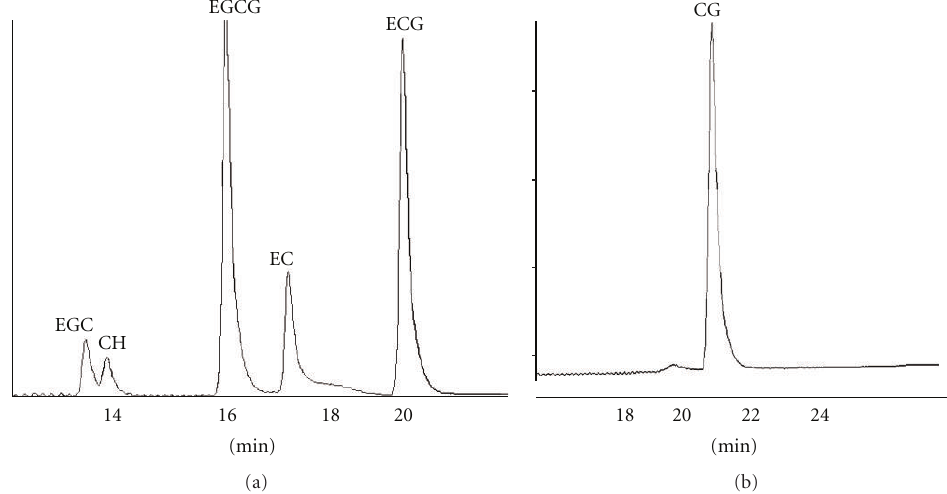
Figure 3: (a) HPLC chromatograms of standard catechins (EC: ( − )-epicatechin; ECG: ( − )-epicatechin gallate; EGC: epigallocatechin; EGCG: epigallocatechin gallate; CH: (+)-catechin Hydrate); (b) chromatogram of ( − )-catechin gallate standard.